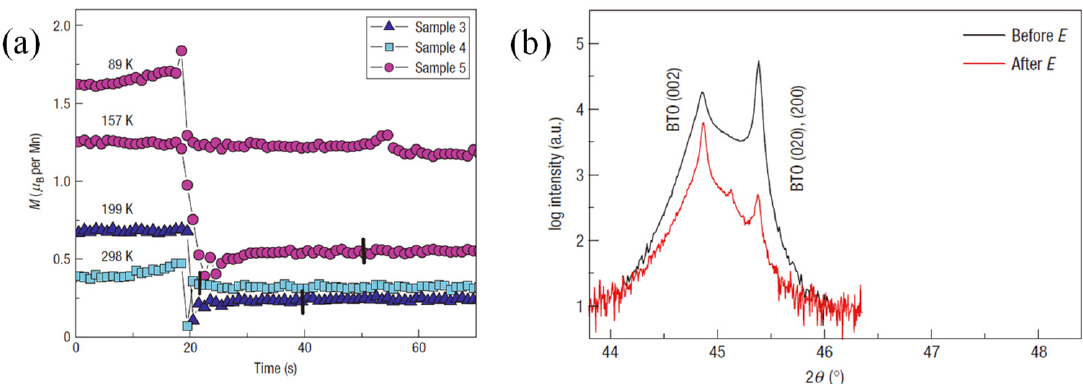
Figure 4. Representative experimental work of strain-driven electric-field control of magnetization in the La 0.67 Sr 0.33 MnO 3 /BaTiO 3 heterostructure. The nonvolatile electric-field control of magnetization ( a ) and corresponding FE domain switching ( b ) in the La 0.67 Sr 0.33 MnO 3 /BaTiO 3 heterostructure. Reproduced with permission from reference [25].